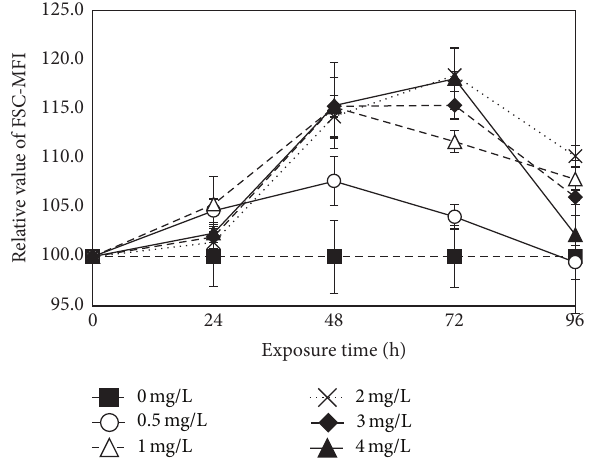
Figure 9: The effects of ethyl cinnamate on the size of the C. vulgaris